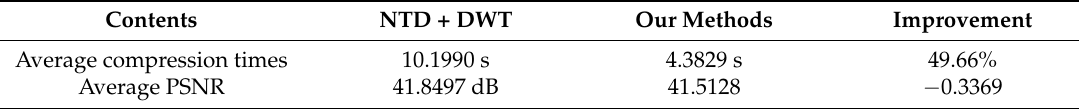
Table 5. Comparison of the computation efficiency and compression performance.